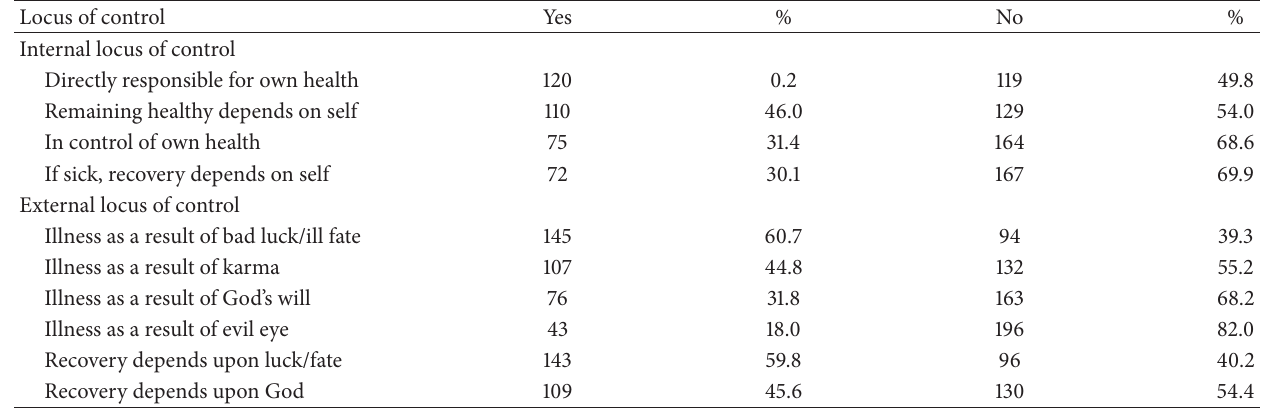
Table 8: Locus of control and health outcomes ( 𝑁 = 239 ).